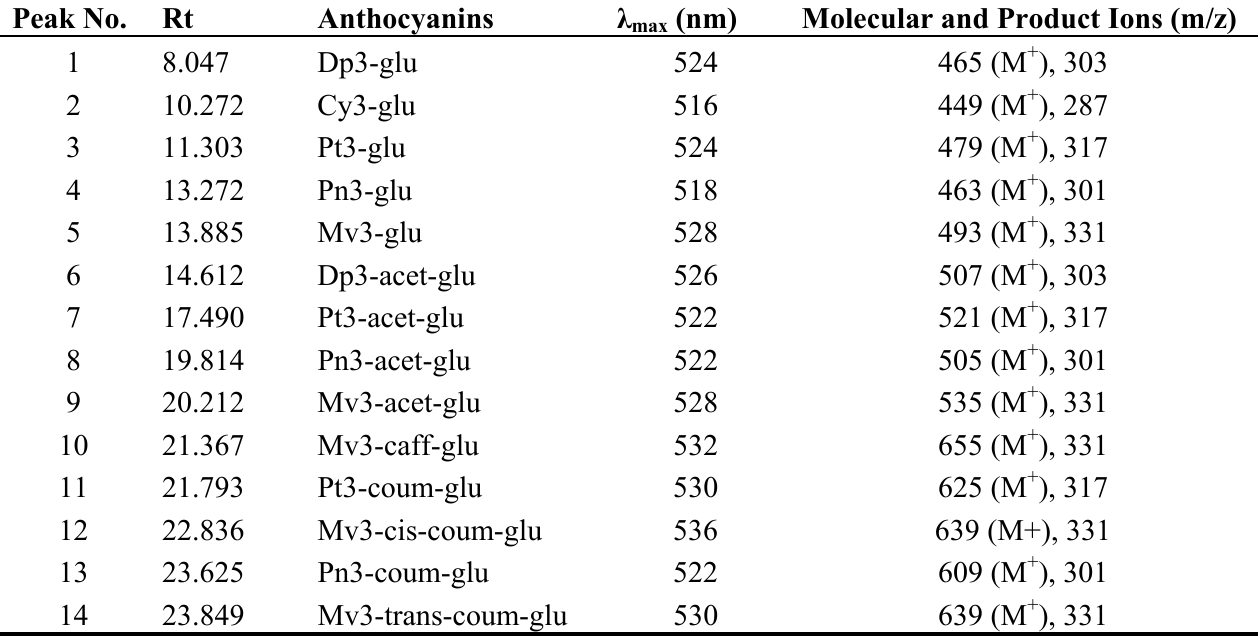
Table 1. Monomeric anthocyanins in Cabernet Sauvignon wines. Peak